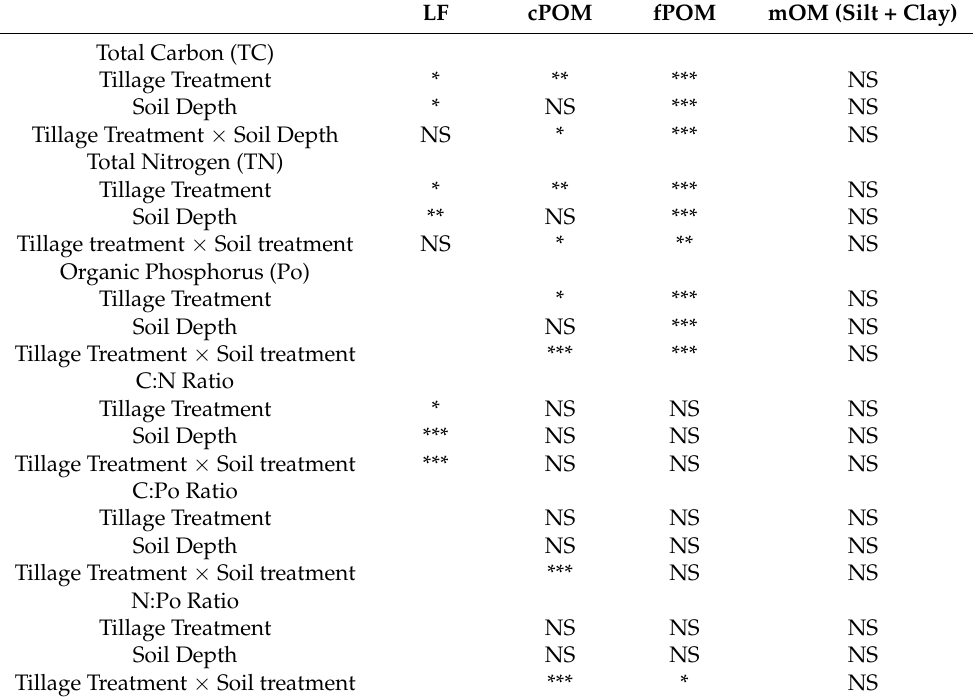
Figure 4. Percentage (%) of total of total carbon (TC); ( a ), total nitrogen (TN); ( b ), and organic phosphorus(Po); ( c ) of SOM fractions by physical fractionation of Andosols from no-tillage (NT) and conventional-tillage (CT) systems. Table 1. Summary of effects of no-tillage (NT) and conventional-tillage (CT) at various depths on the TC (gC kg − 1 soil), TN (gN kg − 1 soil), and Po (gP kg − 1 soil) content, as well as C, N, and Po ratios according to analysis of variance